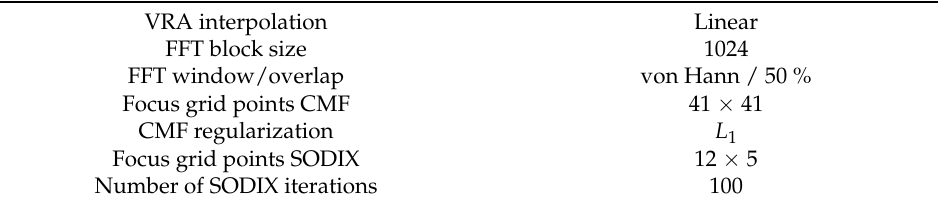
Table 3. Inverse microphonemethod